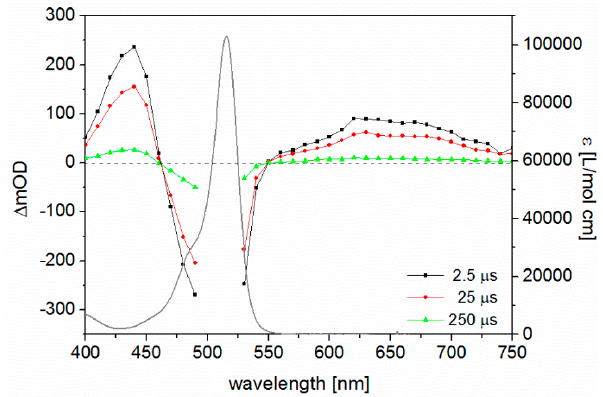
Figure 2. Transient absorption spectra of 5 in THF at chosen delay times (black, red and green) upon excitation with pump pulses centred at 515 nm and stationary absorption spectrum (grey).